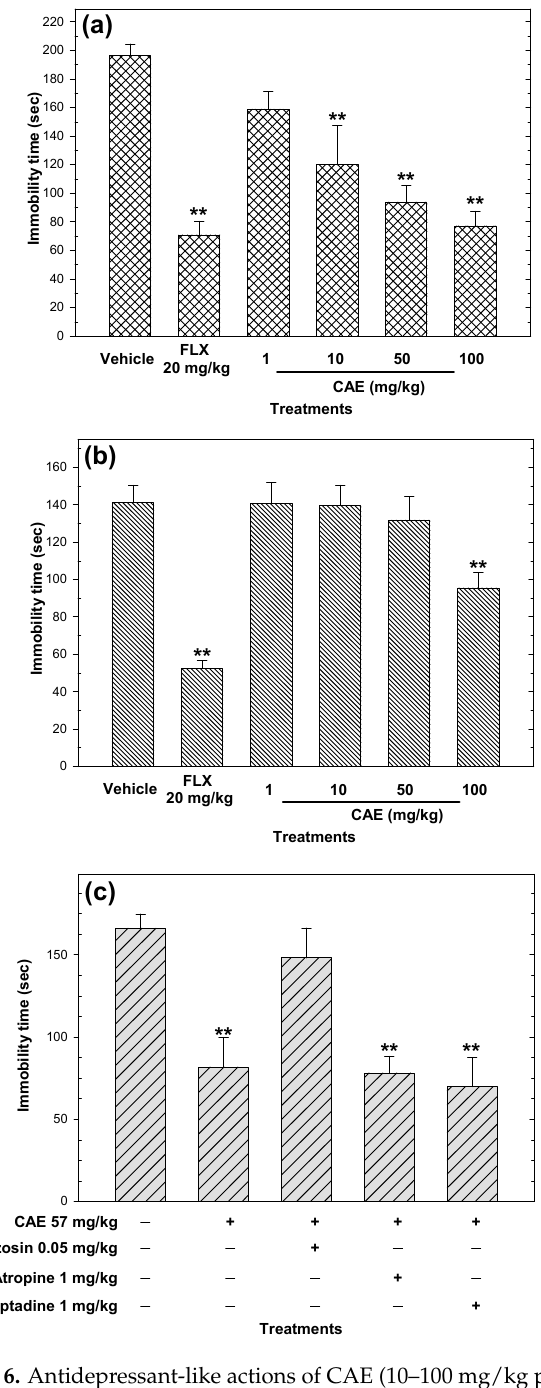
Figure 6. Antidepressant-like actions of CAE (10–100 mg/kg p.o.) evaluating the time of immobility in the tail suspension test ( a ) and forced swimming test ( b ). The possible mechanism of action of CAE was evaluated in the tail suspension test ( c ). Fluoxetine (FLX) at 20 mg/kg p.o. was used as the positive control. Bars represent mean values (± SEM) for the experimental group. n = 8, ** p < 0.05 compared to the vehicle group.